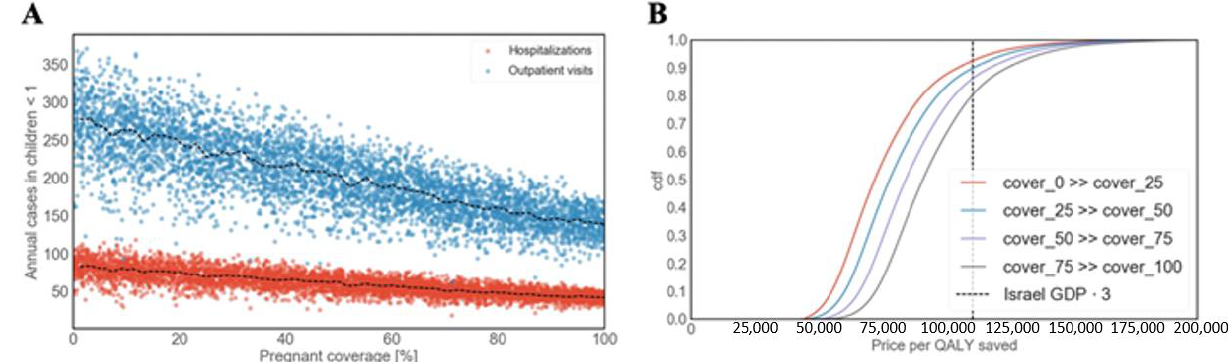
Figure 6. Cost-effectiveness of maternal vaccination. ( A ) Projection of pertussis outpatient visits and hospitalizations for different vaccination uptake in pregnant women based on our model. Results are shown for children in their first year of life. ( B ) Cost-effectiveness of increasing maternal vaccination coverage starting at four different coverage levels.